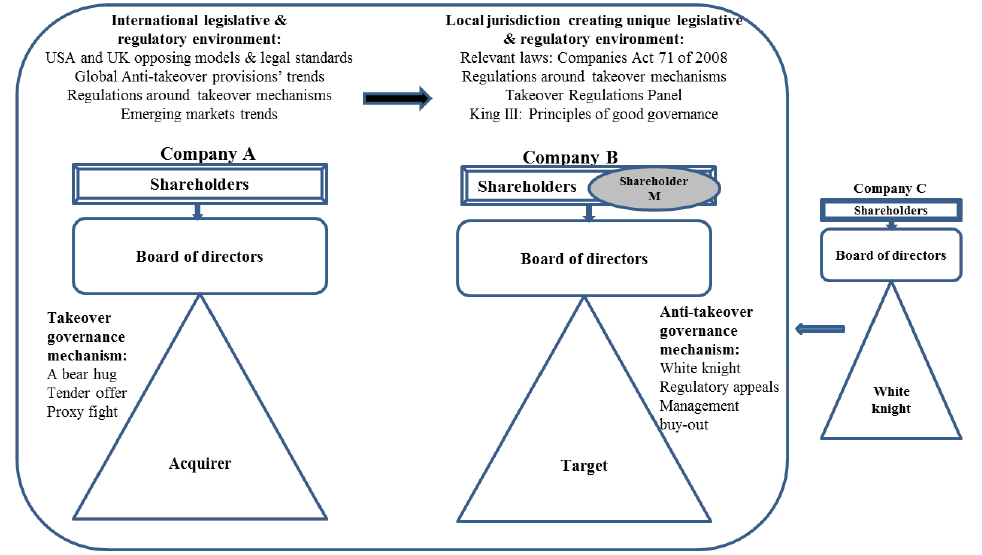
Figure 1: Diagram showing role players during hostile takeovers Research